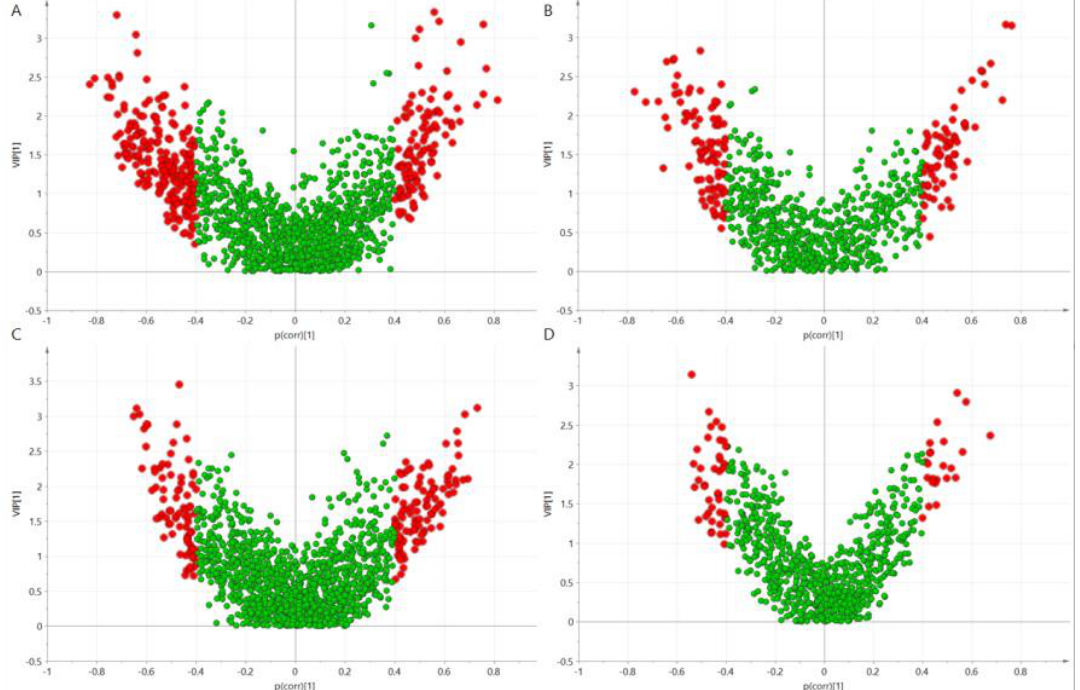
Figure 1. Volcano plots build on the Partial least square discriminant analysis (PLS-DA) models computed based on the area under the curves (AUCs) of plasma metabolites after norma-carbohydrate (NC)-meal for ESI + ( A ) and ESI- ( B ) and high carbohydrate (HC)-meal for ESI + ( C ) and ESI- ( D ). Red color marks metabolic features significantly differenting HR-genotype (CC) and LR-genotype (CT/TT) carriers.